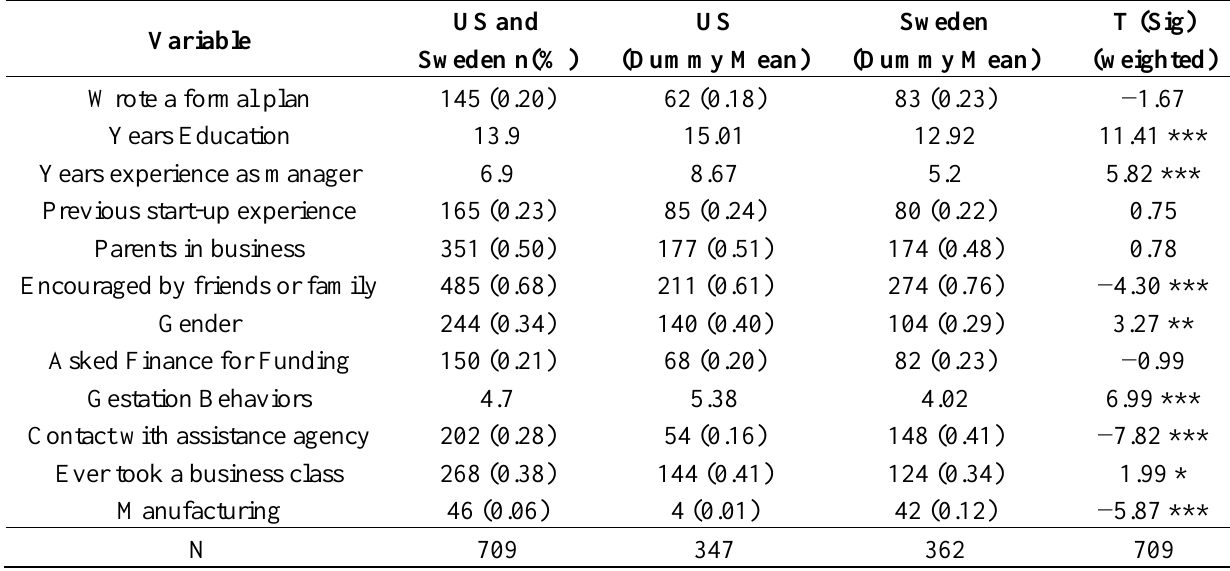
Table 2. Nascent entrepreneurs: descriptive statistics